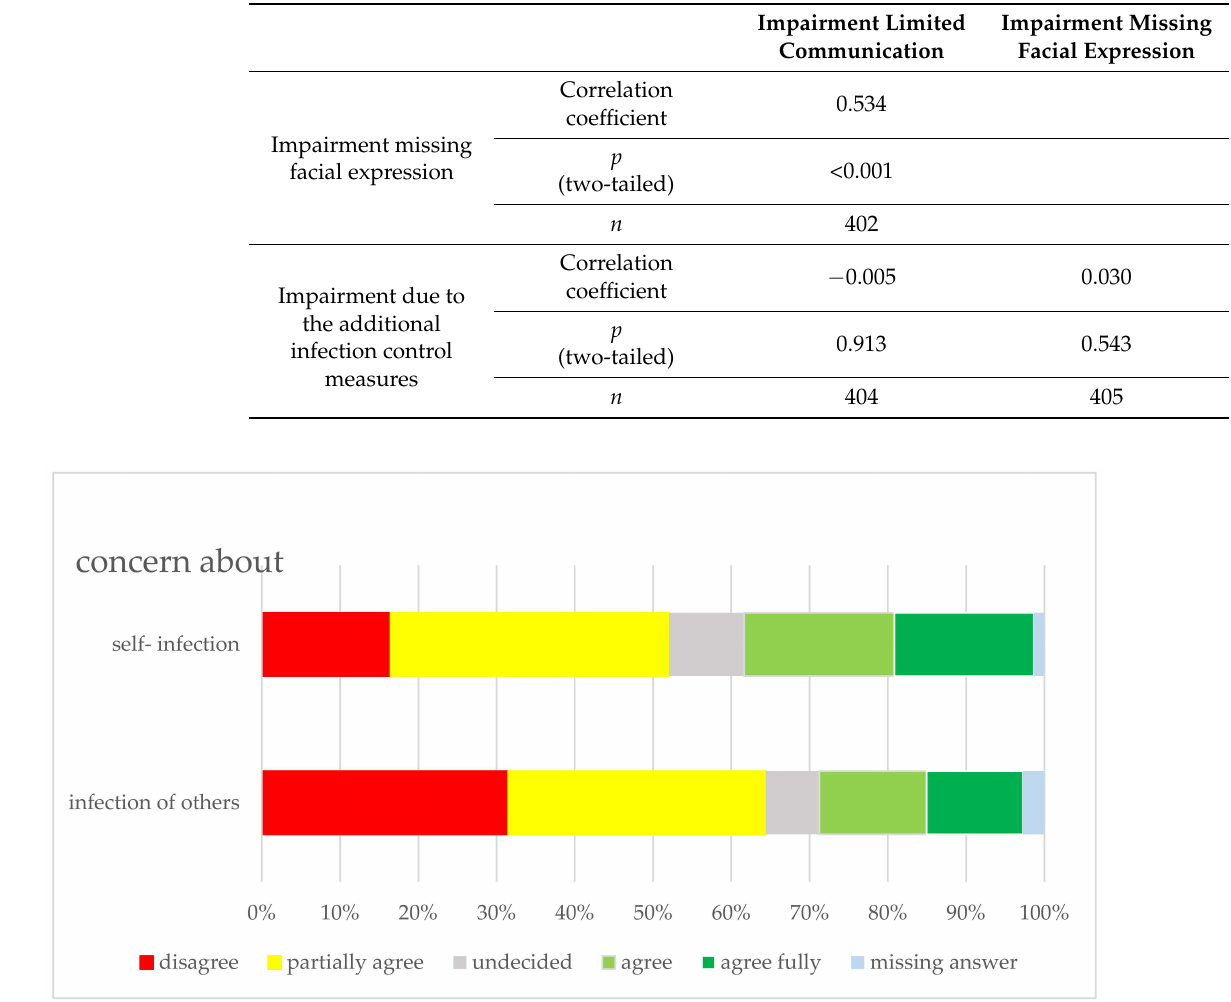
Figure 4. Accompanying changes in daily routine during COVID-19 compared to before the pandemic. Table 1. Spearman’s correlations between impairments of additional infection control measures.